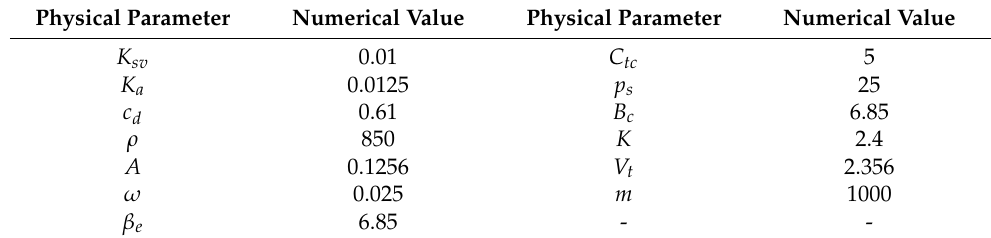
Table 1. Nominal values of hydraulic servo system parameters.